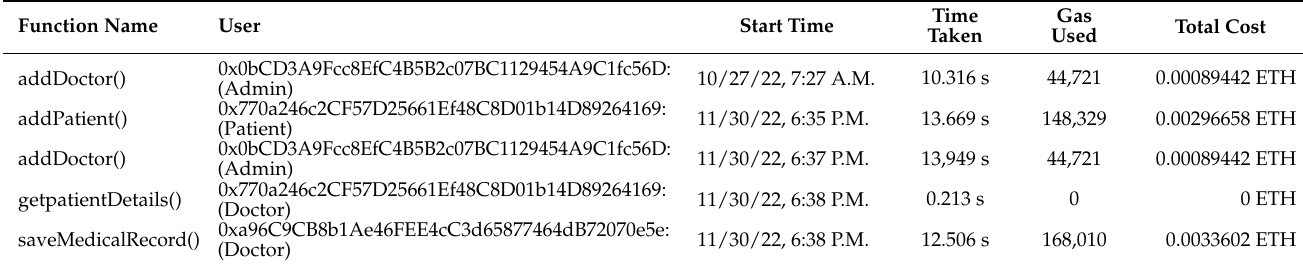
Table 6. PCEHRM time and cost analysis